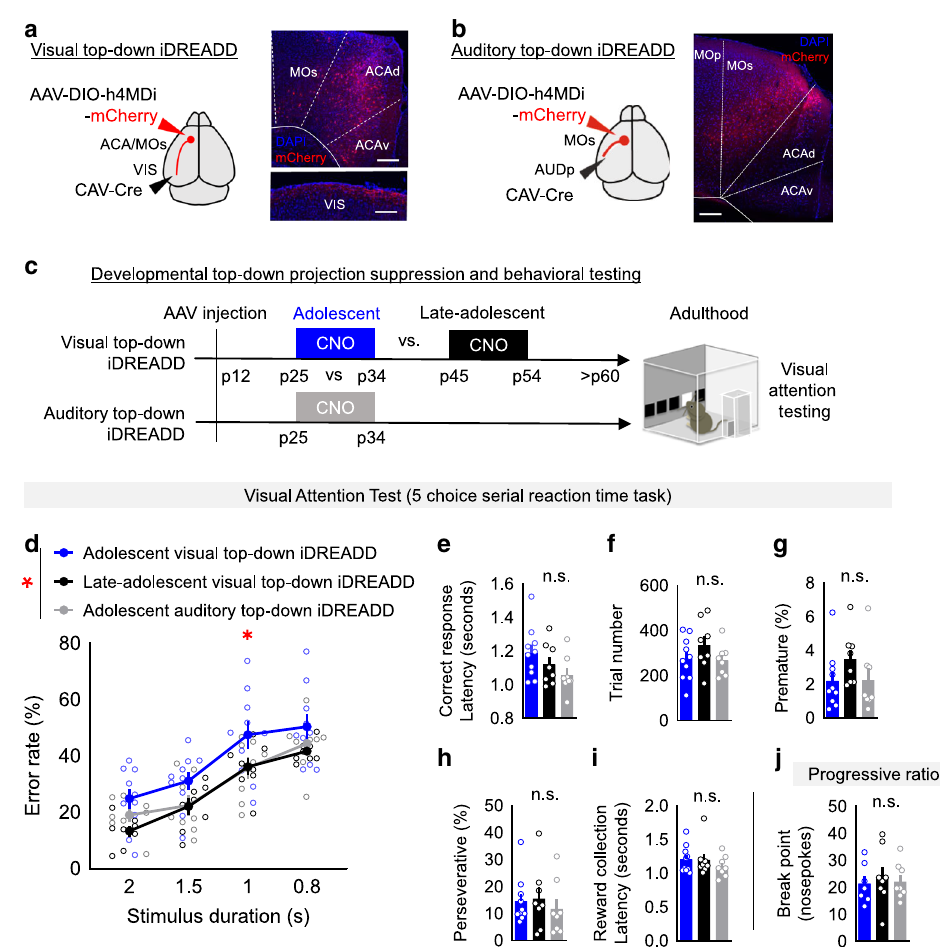
Fig. 5 Suppression of adolescent ACA VIS neuron activity produces a visual attention de fi cit in adulthood. a , b (Left) Schematic of intersectional viral approach to introduce hM4D(Gi)-inhibitory DREADD (iDREADD) selectively into ( a ) frontal visual top-down ACA VIS projection neurons, or ( b ) frontal auditory top-down MOs AUD projection neurons by introducing Cre-dependent iDREADD vectors into the frontal cortex and retrograde Cre encoding